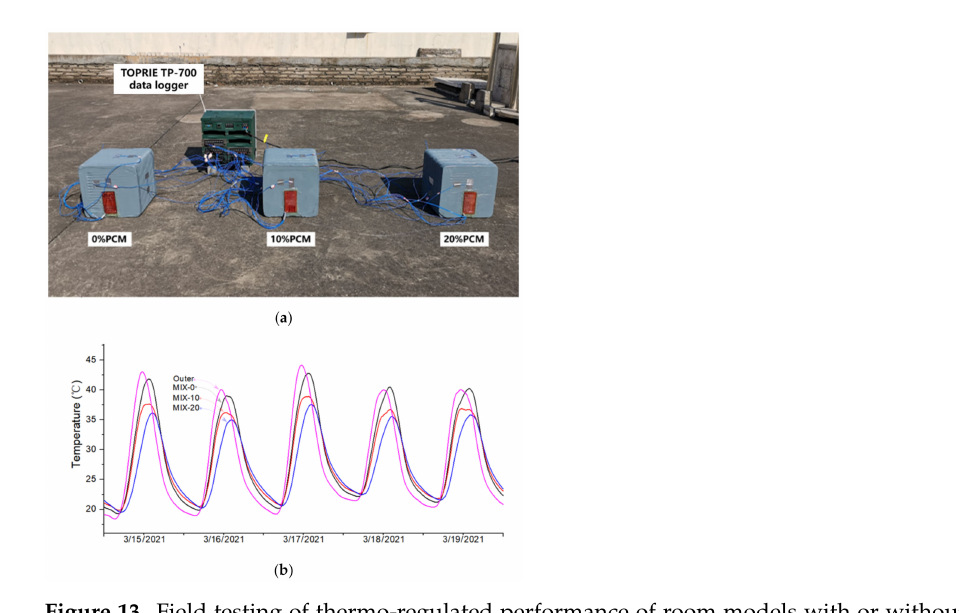
Figure 13. Field testing of thermo-regulated performance of room models with or without PCM: ( a ) field test of the room model (six sensors were placed in each model, but only the inner sensors were used for this study) and ( b ) temperature variations in the room